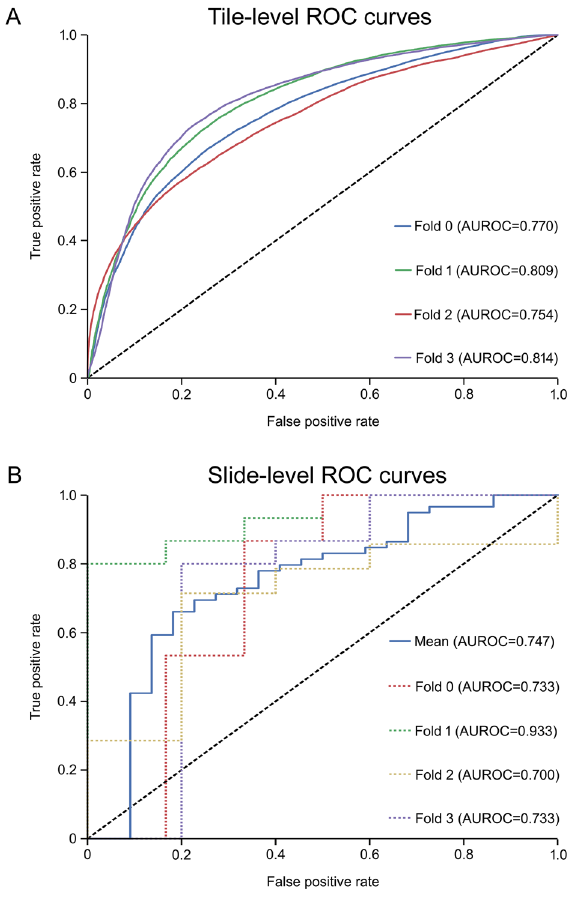
Figure 1. Receiver operating characteristic (ROC) curves and area under the receiver operating characteristic (AUROC) curve scores of the final rapid metastasis -AI-model. ( A ) Tile-level and ( B ) Slide-level results with different fourfold cross-validation folds are